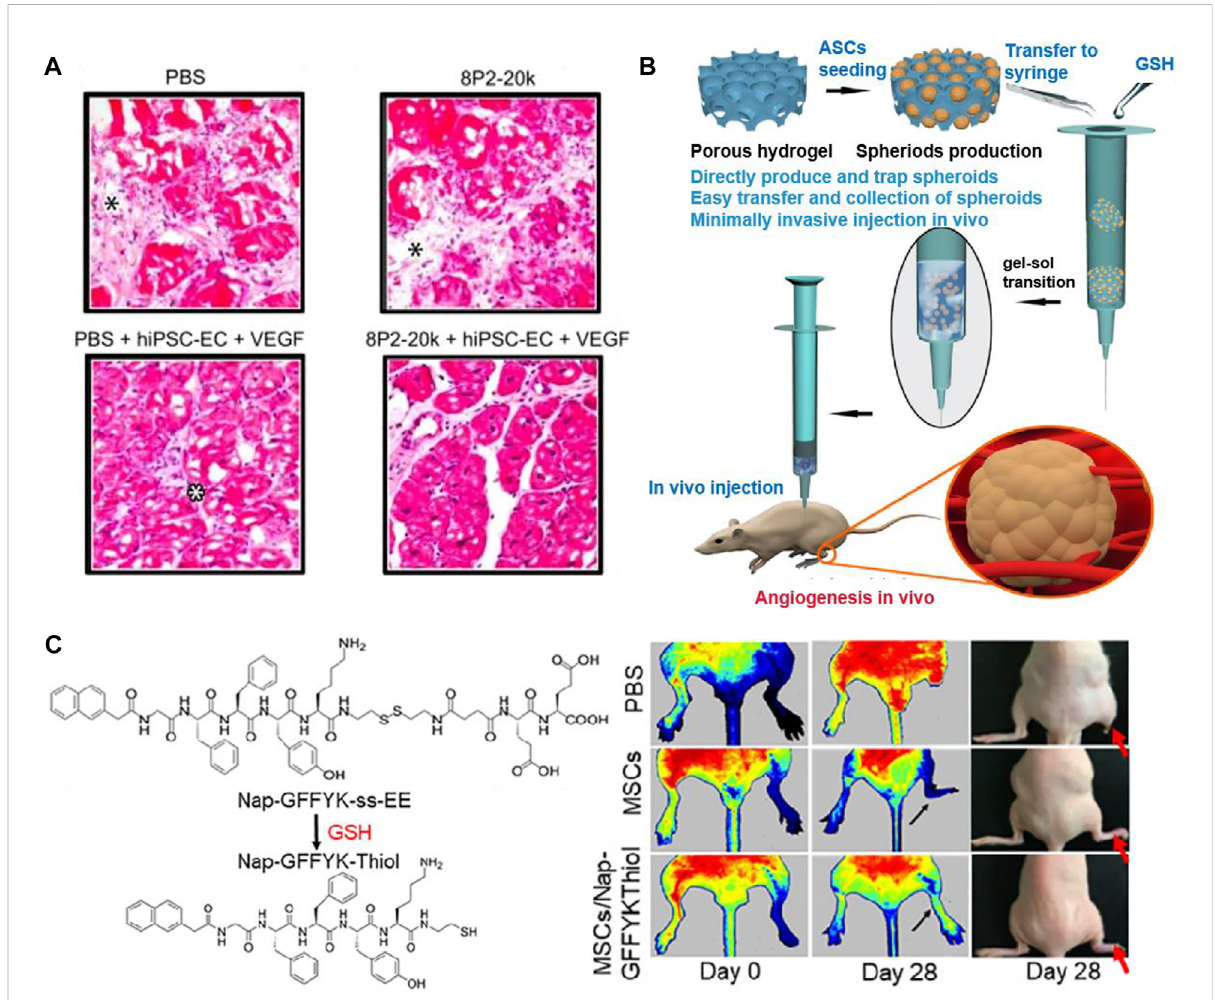
FIGURE 9 Schematic diagrams of several synthetic hydrogels to improve angiogenesis. (A) Representative images of H&E staining showed the effect of PEG hydrogel, which co-deliver hiPSC-ECs and VEGF. Only the protein-PEG co-deliver system group showed no signi fi cant in fl ammation. Black asteriskindicatestheexpansionofconnectivetissueandwhiteasteriskindicatesin fl ammatorycells. (B) GeneraldiagramofthepreparationofPLGA- Cys-mPEG porous hydrogel and the in vivo result of angiogenesis. (C) Chemical structures of Nap-GFFYK-Thiol hydrogel and LDPI images of bloodperfusion. (A) isreprintedwith permission fromref. (Mulyasasmita etal.,2014). (B) isreprinted withpermissionfrom ref.(Hongetal., 2020). (C) is reprinted with permission from ref. (Huang et al.,